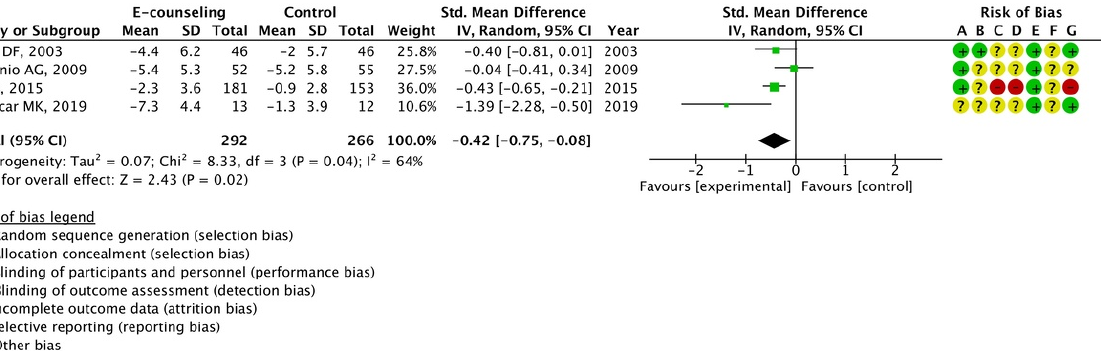
Figure 5. Meta-analysis for mean weight change with or without personalized information using 5 articles [16,17,26,31,50]. The forest plot shows standardized mean differences (SMD) for each article with 95% confidence intervals (CI). The diamond at the bottom of the graph means the meta-analyzed measure of effect and the lateral points of which indicate CIs for this estimate. A positive value reflects web-based interventions with personalized information are more effective for weight loss than web-based interventions without personalized information. The area of each green square is proportional to the study's weight in the meta-analysis.